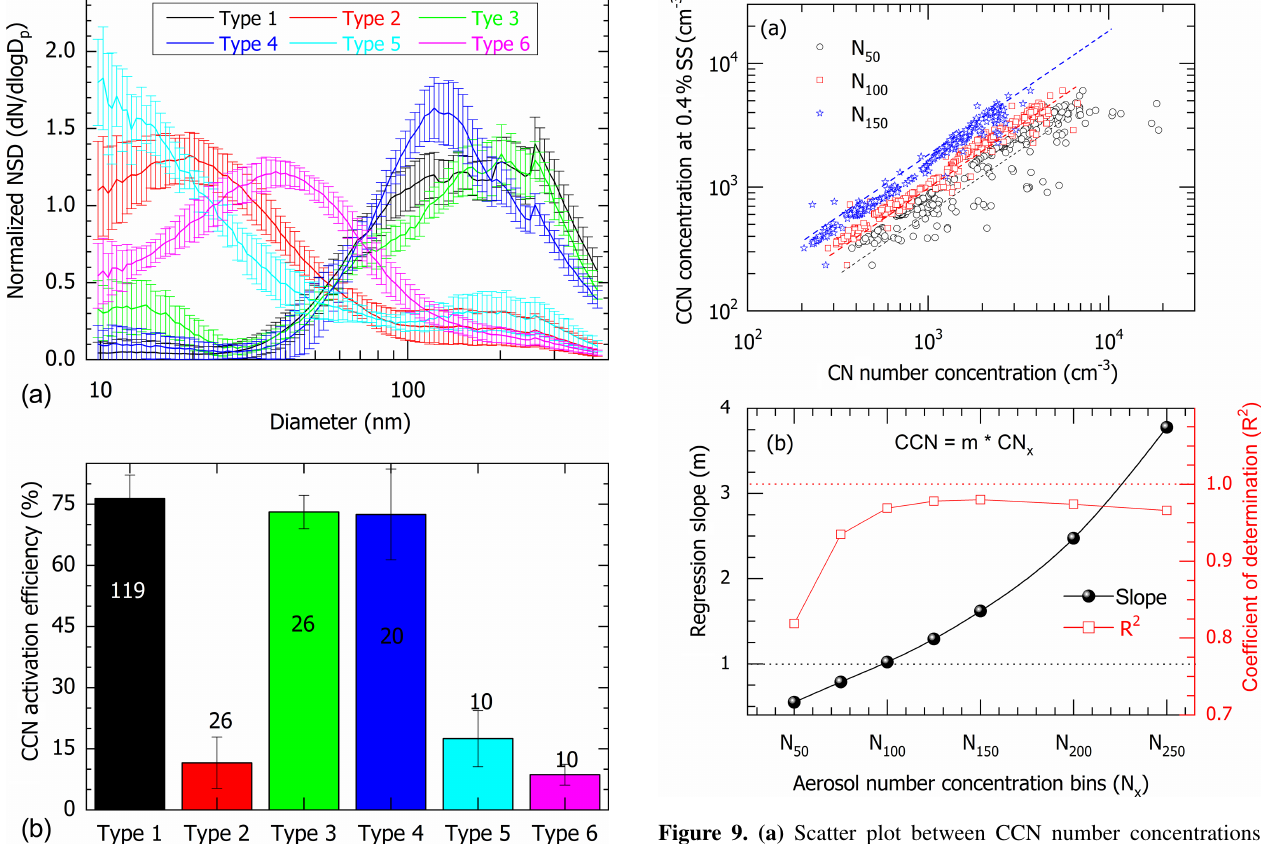
Figure 8. (a) Most frequently occurring aerosol number size distri- butions (normalized) during ICARB-2018. Vertical bars represent the standard deviation of the data, and the number of hourly obser- vations averaged for each distribution is given in (b) . (b) Activation efficiency at 0.4% supersaturation of the normalized distributions shown in panel (a) .